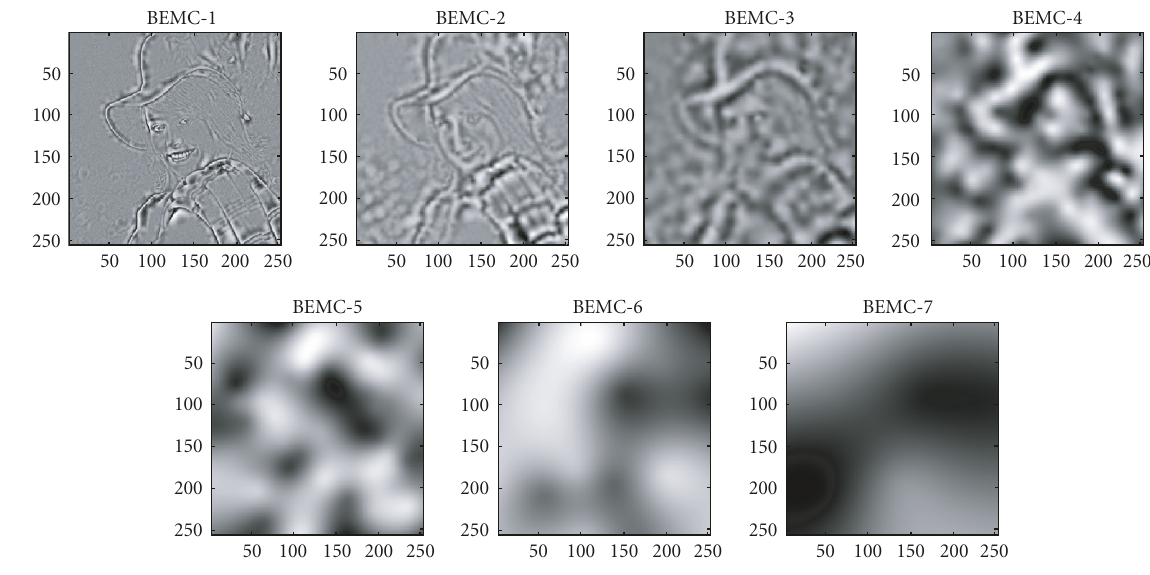
Figure 22: BEMCs of Elaine image obtained by BEMD with RBF-TPS (MNAI = 10).